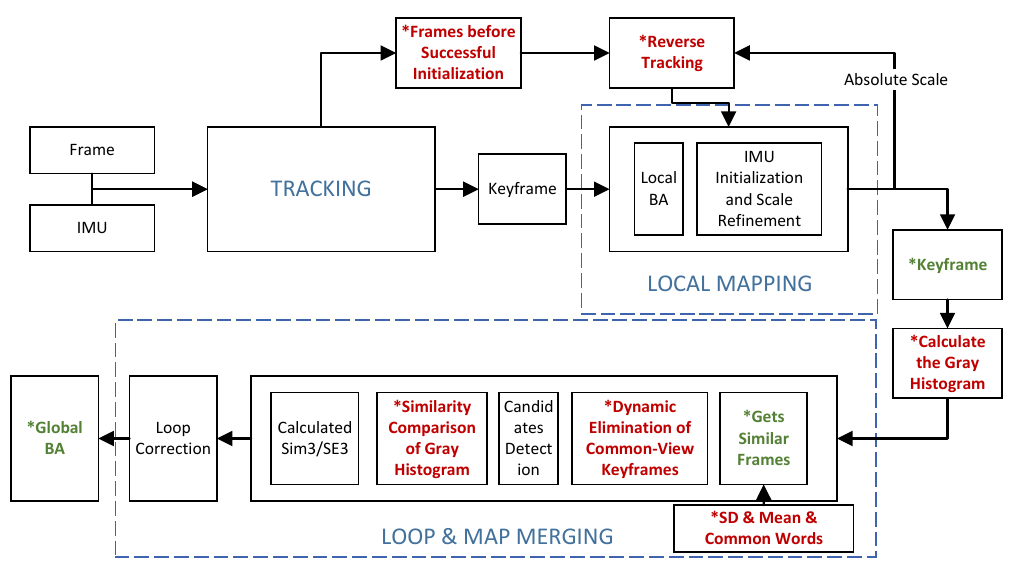
Figure 1. System overview. Our system pipeline is an extension of ORB-SLAM3 [17]. Compared with ORB-SLAM3, the main improvements of our system have been marked with “*” in the flowchart. The red part indicates new additions, and the green indicates